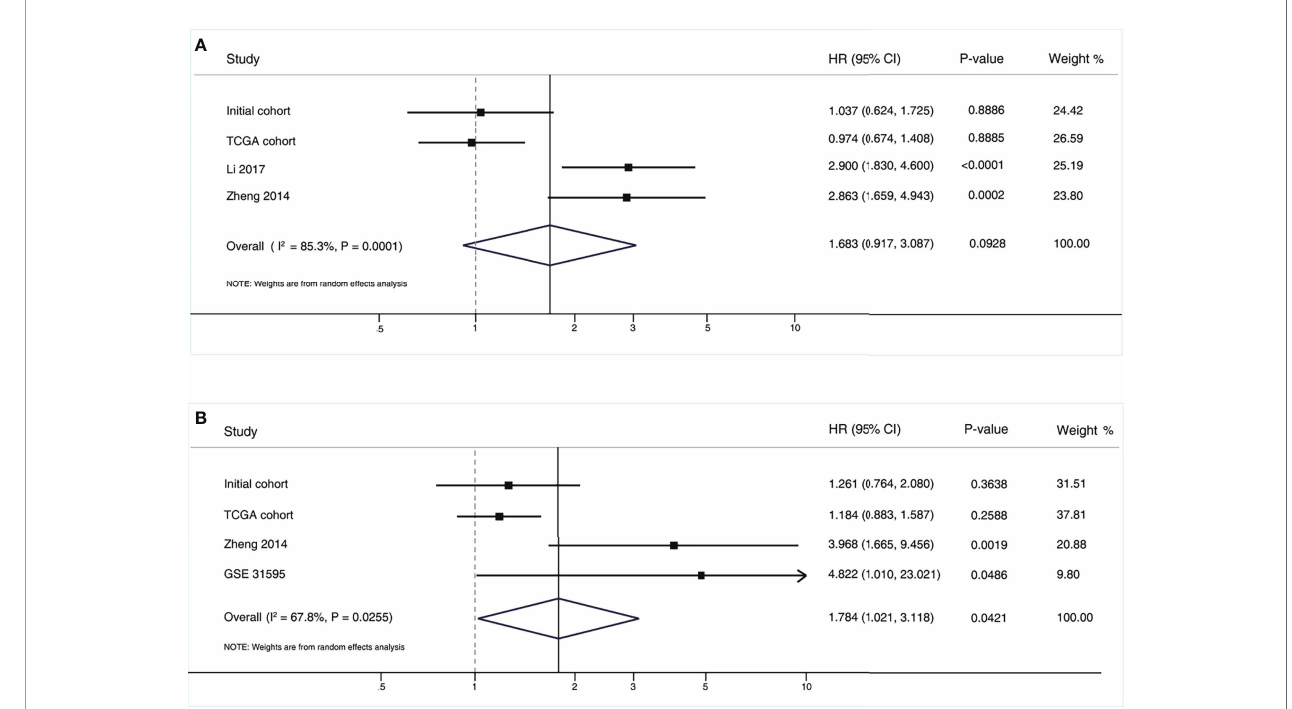
FIGURE 2 | Pooled results of the meta-analysis for MALAT1 expression and colorectal cancer outcomes. (A) Overall survival; (B) Disease free survival. CI, con fi dence interval; HR, hazard